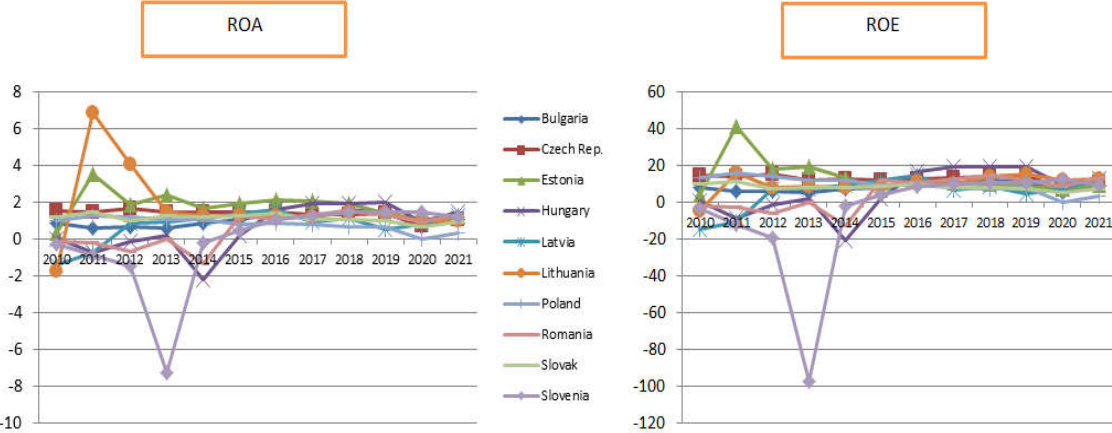
Figure 1. Return on assets (ROA) and return on equity (ROE) in CEECs, %. In most of the countries included in the analysis, ROA recorded positive values that fell within the range of 1–2%, with a few exceptions that are important to mention because they will represent future outliers in the econometric analysis. First of all, Lithuania shocked by jumping from the value of −1.72% recorded in 2010 to no less than 6.89% in 2011, being the country with the highest ROA among those analyzed in the period 2010– 2021. According to Novickytė and Droždz, the profitability of Lithuanian banks is increas- ing due to significantly decreased interest expenses and increased efficiency [61]. Another exceptional situation was found in Slovenia, a country where the ROA suffered a signifi- cant and sudden drop from −1.48% in 2012 to −7.29% in 2013. This decrease is explained by the fact that the quality of loan portfolios had continuously deteriorated, but also by the need for large banks with state capital to receive additional capital [62]. Still other exceptions, but of a smaller scale, were Estonia with a positive value of ROA in 2011 of 3.54% and Hungary with a negative value of ROA of −2.24%. Return on equity measures a company’s (in our case, banking system's) net income divided by shareholders’ equity. The values of this indicator fell within the range of 0– 20% for the entire time period analyzed, with a few exceptions. It is thus worth noting the positive value of ROE registered by Estonia in 2011, of over 41%. Significant negative and continuously decreasing values of ROE were recorded in Slovenia, reaching the negative historical maximum of 97% in 2013. Negative values of ROE were also recorded in coun- tries such as Hungary (around 20% in 2014) and Latvia (about 15% in 2010) as a result of the effects of the world economic crisis of 2008. Regarding the value of non-performing loans, we found, as an overall assessment, that they had registered a downward trend, in 2021 reaching a percentage below 5% of the total loans issued (less in Bulgaria), but even in the case of this indicator, we found some exceptions, among which it is important to mention Romania, which in 2013 regis- tered a growth point and exceeded 20% in its level of non-performing loans to total loans, together with Latvia and Lithuania, which were in the same situation in 2010.